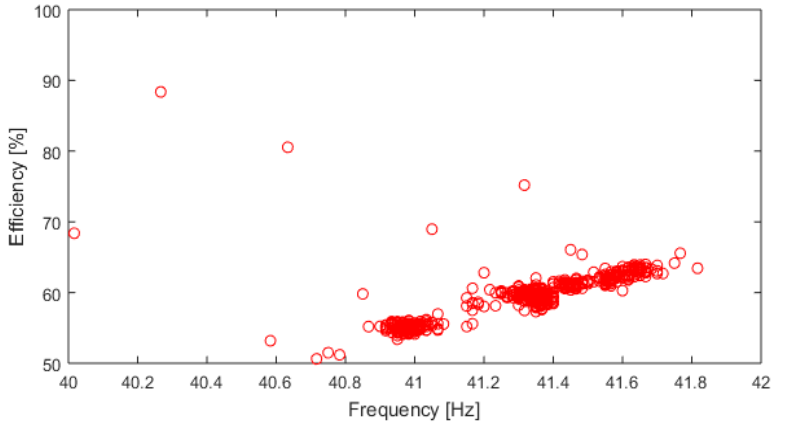
Figure 18. The characteristic F = f ( E Pe,n ) for the hydraulic regime with four pumps in operation.